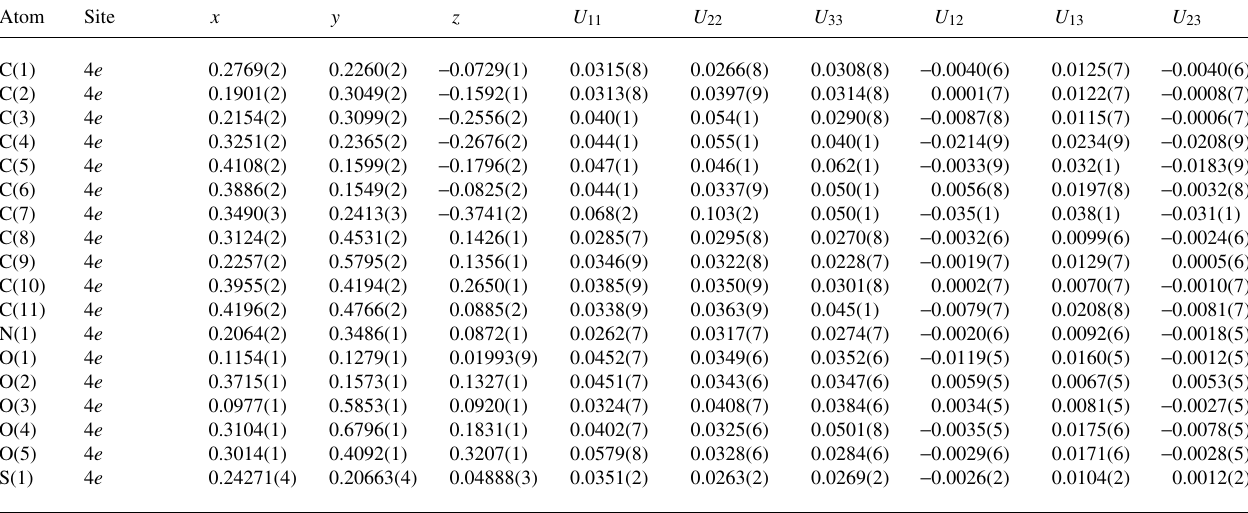
Table 3. Atomic coordinates and displacement parameters (in Å 2 )